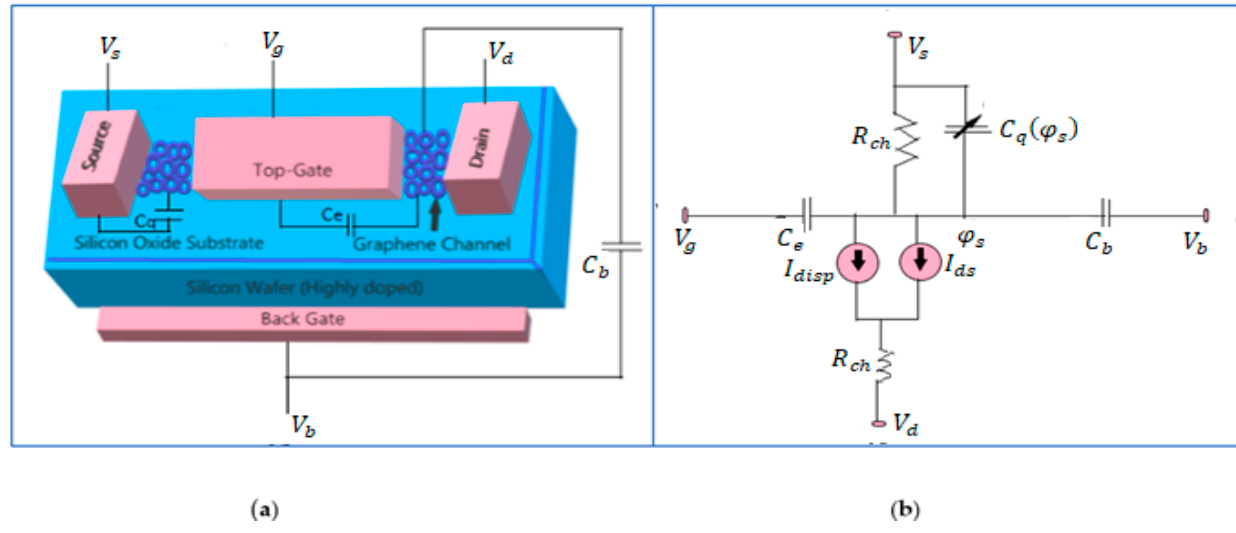
Figure 1. Configuration of a dual-gate graphene field effect transistor. ( a ) The 3D structure of the transistor. ( b ) Electrical equivalent circuit.